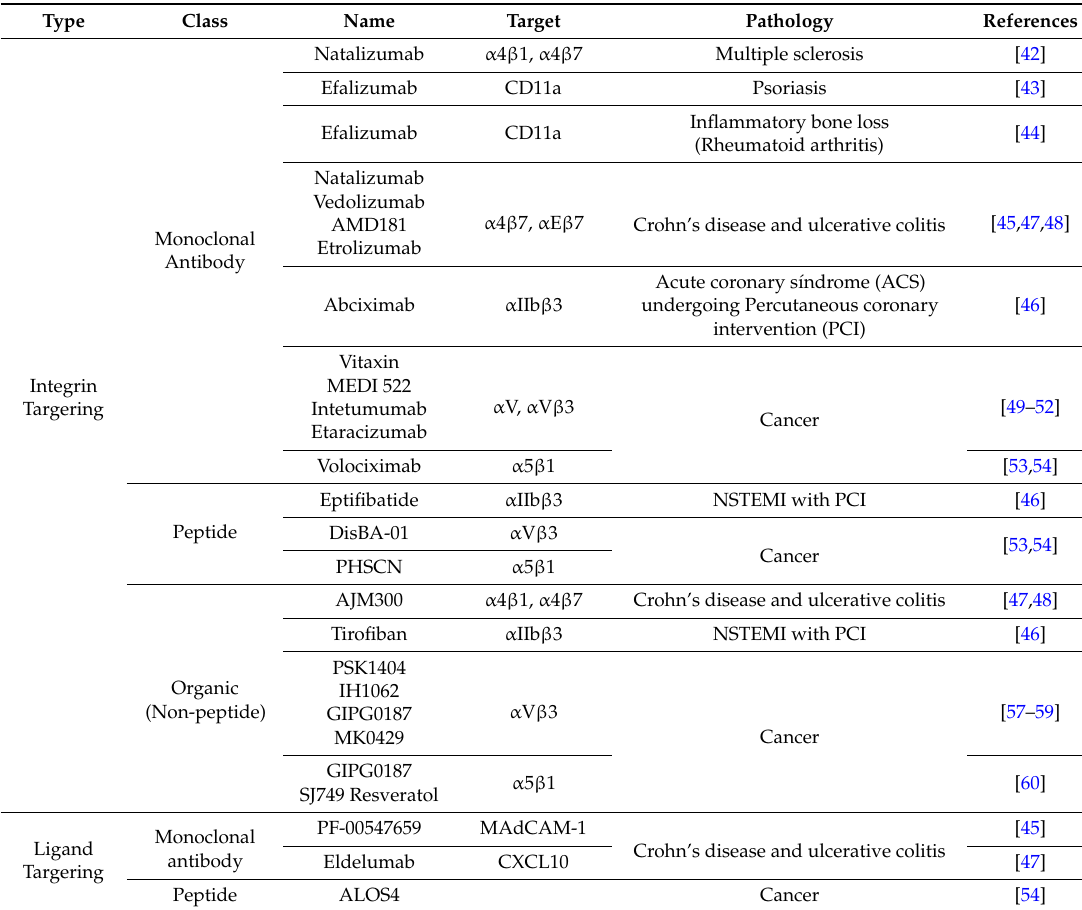
Table 1. Preclinical and clinical trials evaluating drugs and inhibitors against integrins and their ligands in human disease and cancer.